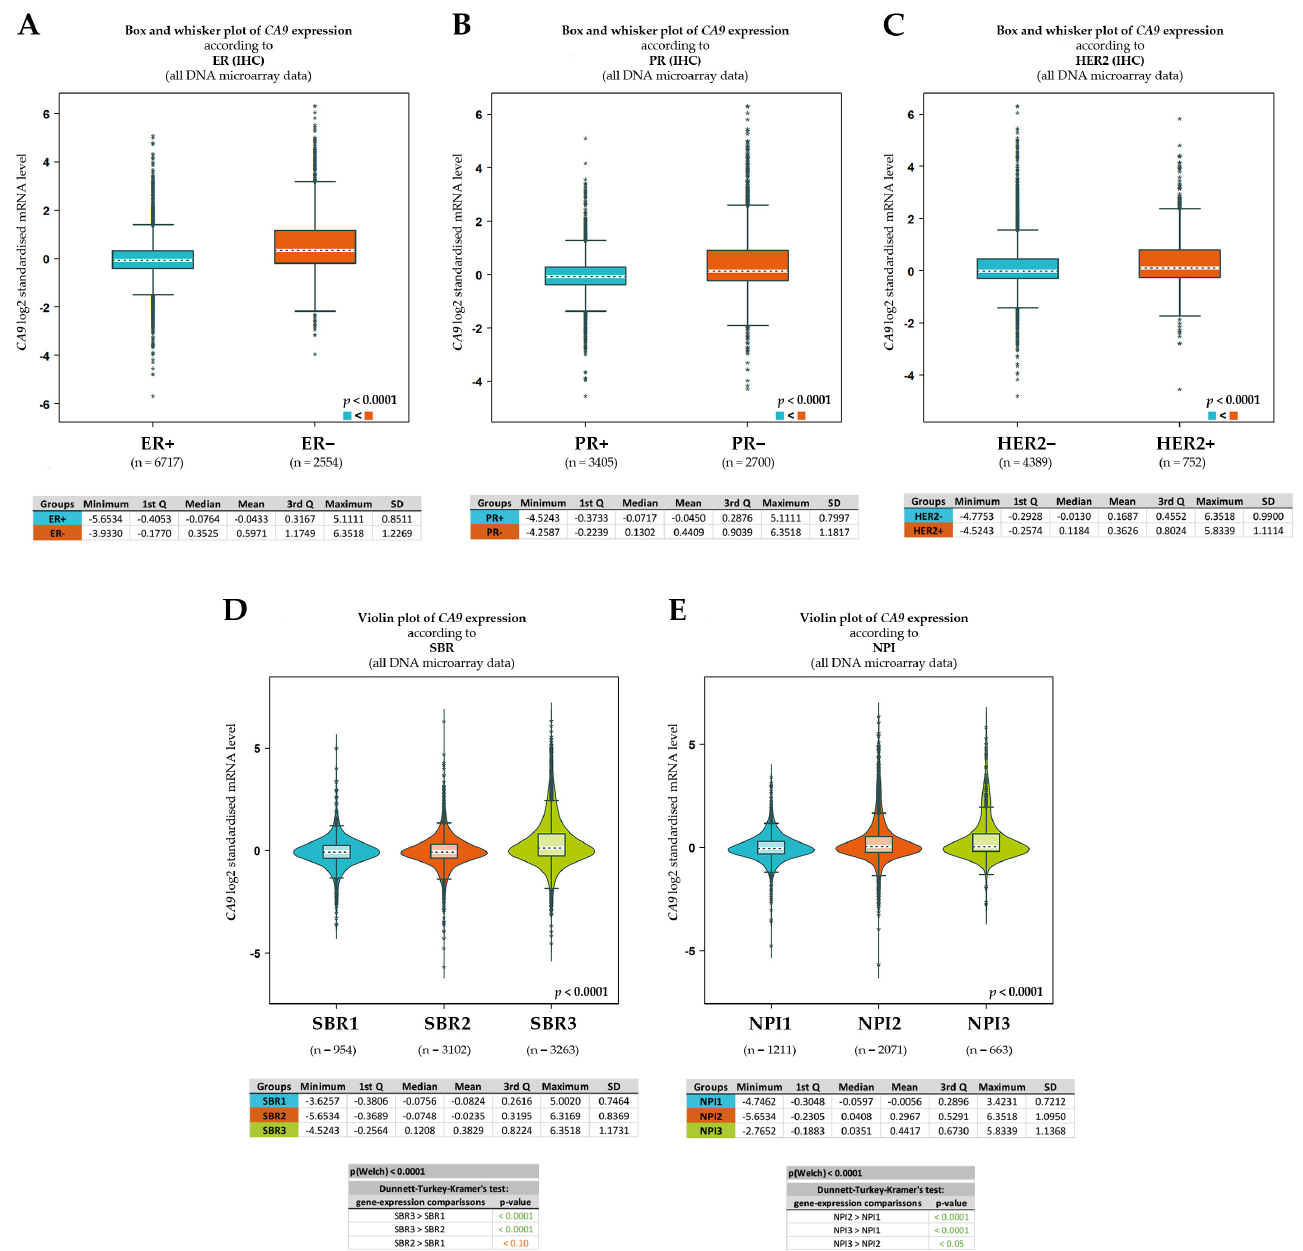
Figure 6. CA9 gene expression analysis according to receptor (ER, PR, and HER2) statuses, Scarff– Bloom–Richardson grade, and Nottingham prognostic index. Expression analysis for CA9 with positive versus negative receptor IHC status: ER ( A ); PR ( B ); and HER2 ( C ) (n = 9335); ( D ) expression